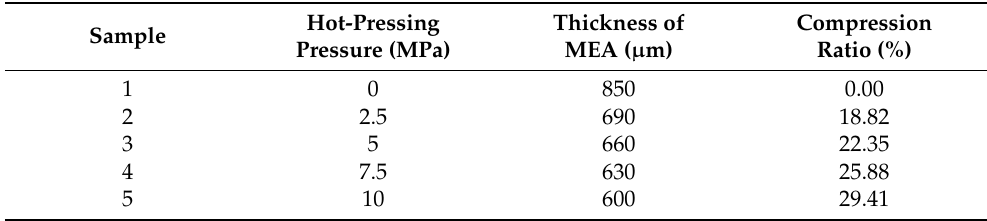
Table 2. The forming thickness and compressibility data of titanium mesh-based MEA under different hot-pressing